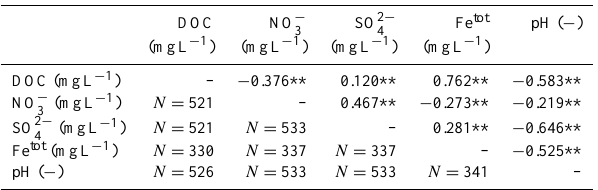
Table 4. Correlations (Pearson) between solutes in pore water. Data for nitrate, sulfate, iron and pH from Knorr et al. (2009), DOC data from Knorr (2007)